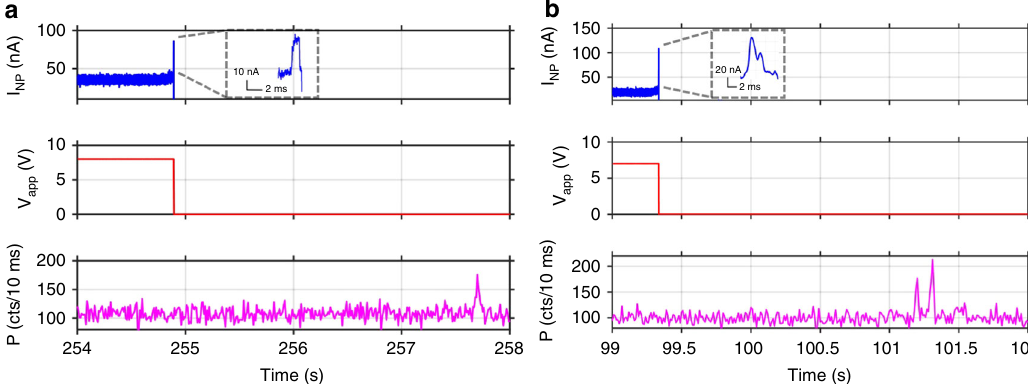
Fig. 5 Fluorescence detection of λ -DNA molecules on demand. a top: Current through pore and electrical detection of a single λ -DNA entering fl uidic channel (dashed box: zoomed-in view of translocation event); center: voltage across the pore preventing further translocations after event has been detected; bottom: Concurrently recorded fl uorescence signal showing optical detection after characteristic transport time. b Introduction and detection of two λ -DNA molecules; the ambiguity of the double-peak electrical signal is removed by the optical detection after both DNA molecules have separated in the channel NATURE COMMUNICATIONS| (2019) 10:3712